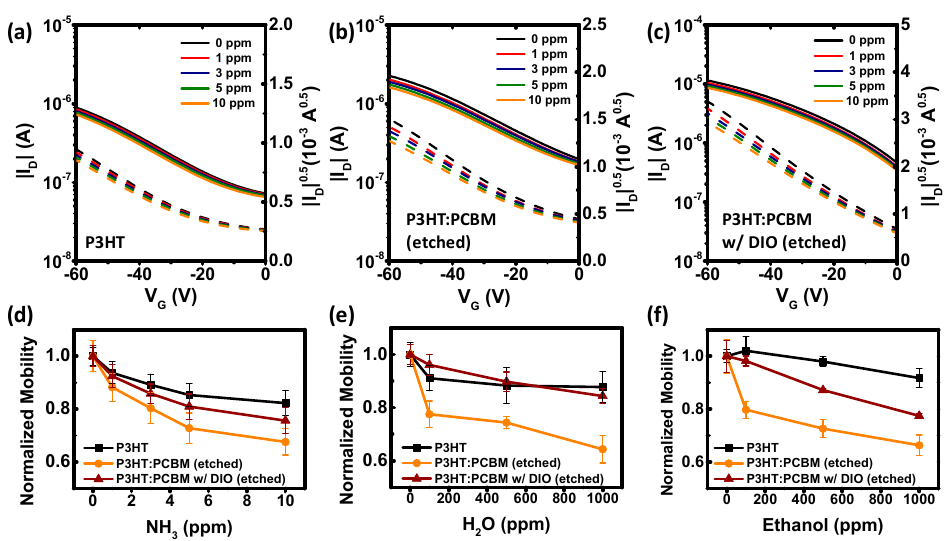
Figure 6. Sensor characteristics of OTFTs based on morphology-controlled P3HT films. ( a – c ) Transfer curves of sensor devices in vaporized ammonium hydroxide: ( a ) the pristine P3HT film, ( b ) the blend film after selective etching, and ( c ) the DIO-added blend film after etching. ( d – f ) Normalized hole mobility of various devices as a function of the analyte concentration: ( d ) NH 3 , ( e ) H 2 O, and ( f ) ethanol. Device testing conditions: W / L = 20 and V D = − 60 V.